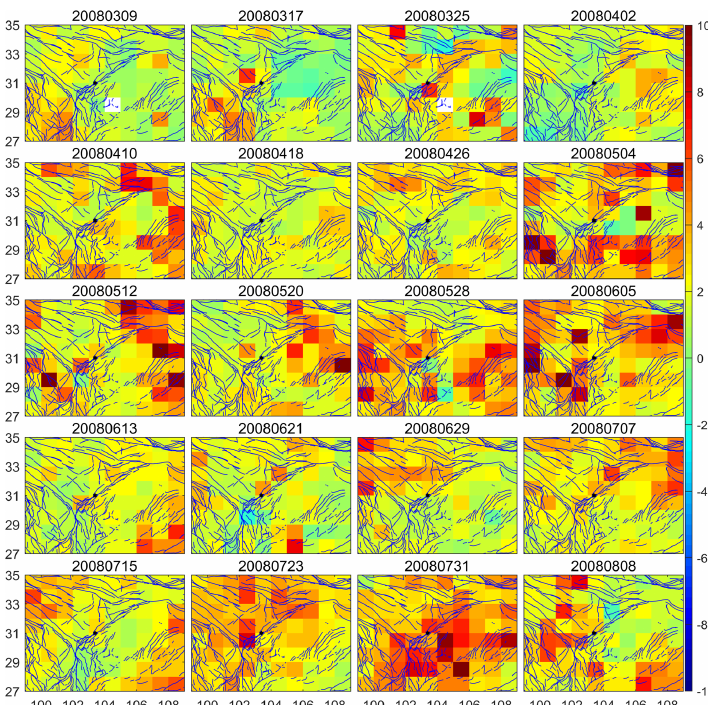
Figure 5. ALICE index of 8d CH 4 VMR at 200hPa.